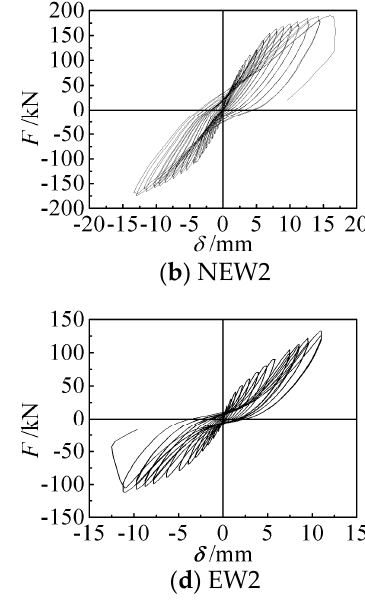
Figure 8. Hysteresis curves of specimens.